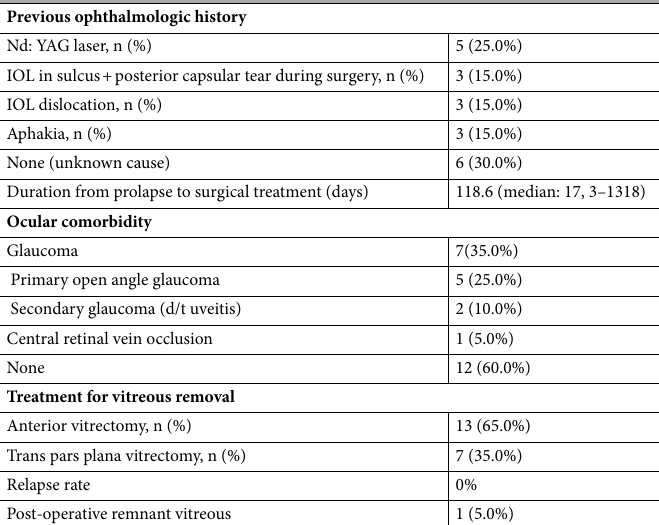
Table 2. Patient factors and treatment of vitreous prolapse. Age, visual acuity, intraocular pressure displayed as mean ± SD N displayed as number (%). logMAR logarithm of the minimal angle of